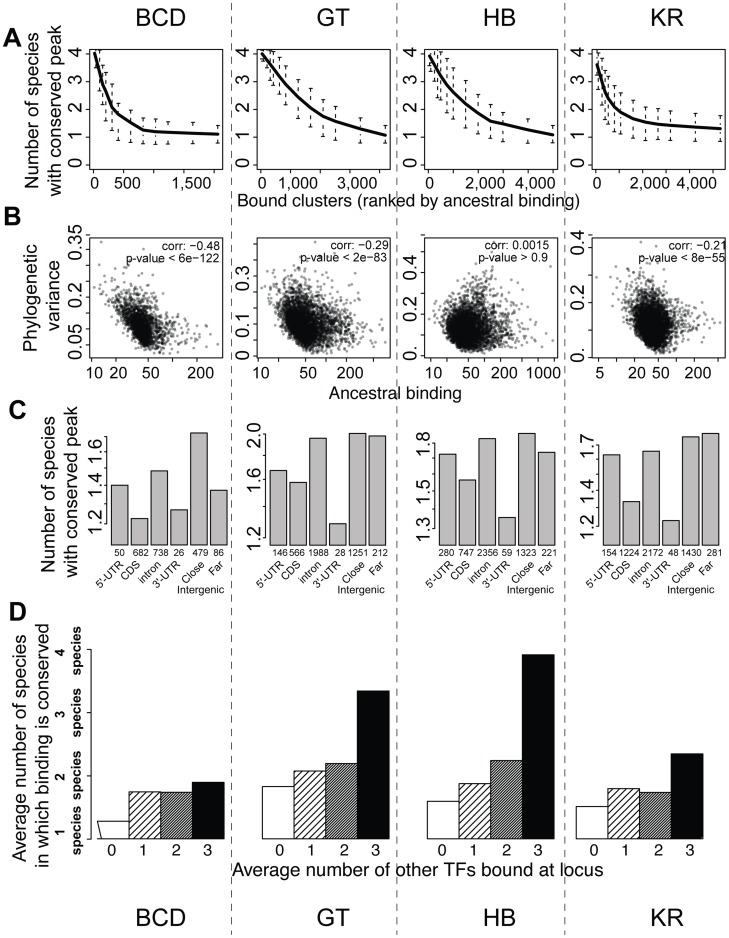
BCD, GT, HB and KR binding events are differentially conserved, and binding predicted to be functional is better conserved.
A. Comparison of qualitative conservation of TF binding in the different species. A conservation score, corresponding to the average number of species in which binding was detected (1–4), was calculated for each set of orthologous regions and ranked according to ancestral mean, as estimated using a Brownian motion model. B. Comparison of binding intensities, as represented by ancestral mean binding, and trans-species binding variance in a Brownian motion model of TF binding evolution. C. Mean binding conservation score (1–4 species) depending on peak location in D. melanogaster. D. Mean binding conservation score depending on the number of other A-P factors binding the same locus. To correct as much as possible for TF binding differences linked to different wiring sizes, clusters were binned into 10 bins, depending on the estimated ancestral values, and the conservation was estimated independently in each bin. The average conservation is displayed. Similar plots were made using different threshold for calling sets of bound orthologous regions (Figures S10 and S11).